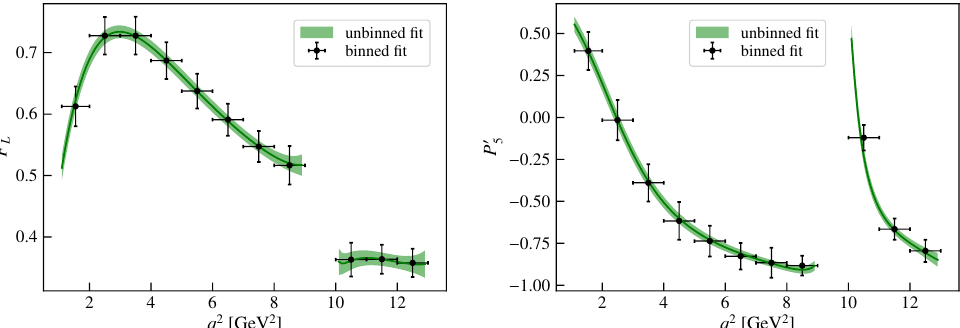
Figure 7 . Angular observables F L and P 0 5 obtained a-posteriori from the unbinned amplitude (cid:12)t results compared with the binned angular analysis. Both approaches analyse the same set of ensembles generated with the BMP scenario and the expected statistics at LHCb Run